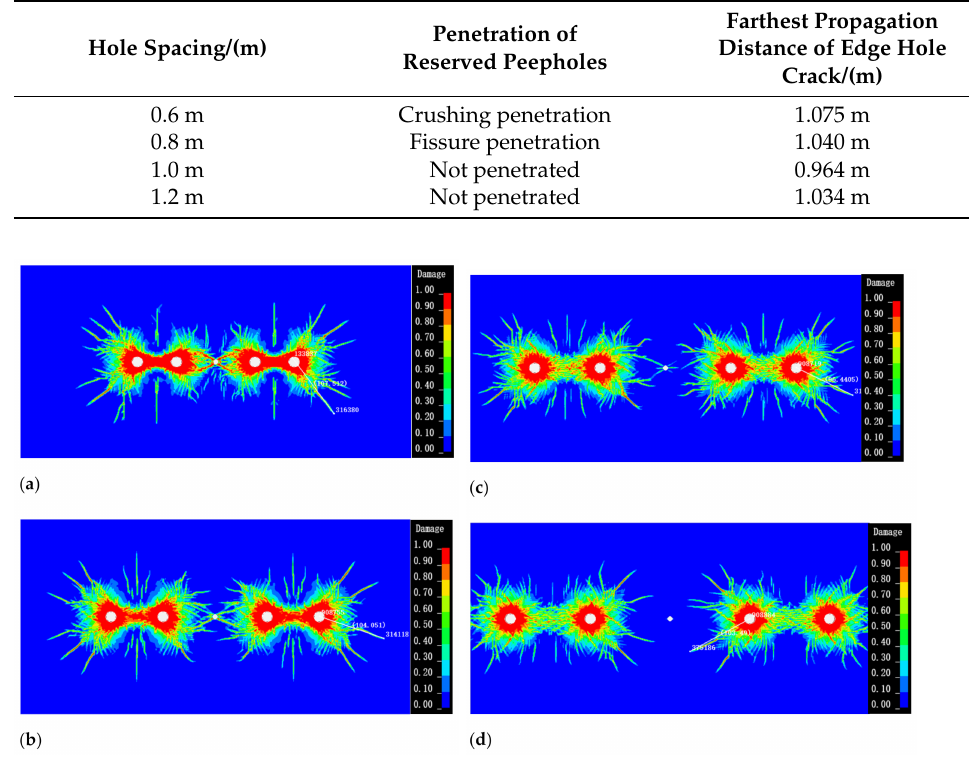
Figure 8. Evolution and distribution characteristics of cracks between blasting roof cutting holes under different hole spacings. ( a ) Blasting hole spacing 0.6 m. ( b ) Blasting hole spacing 0.8 m. ( c ) Blasting hole spacing 1.0 m. ( d ) Blasting hole spacing 1.2